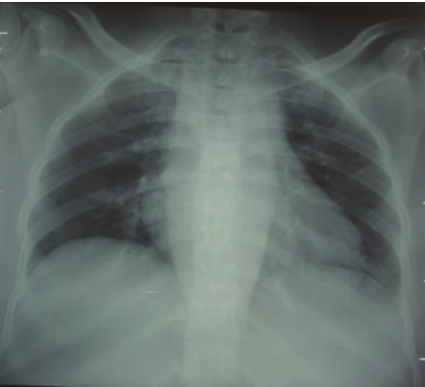
Figure 3: Chest X-ray showing enlargement of the mediastinum, consistent with tuberculous abscess mass.